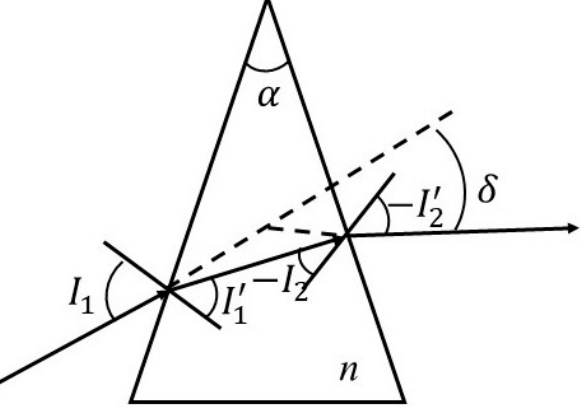
Figure 12. Optical path in the prism.